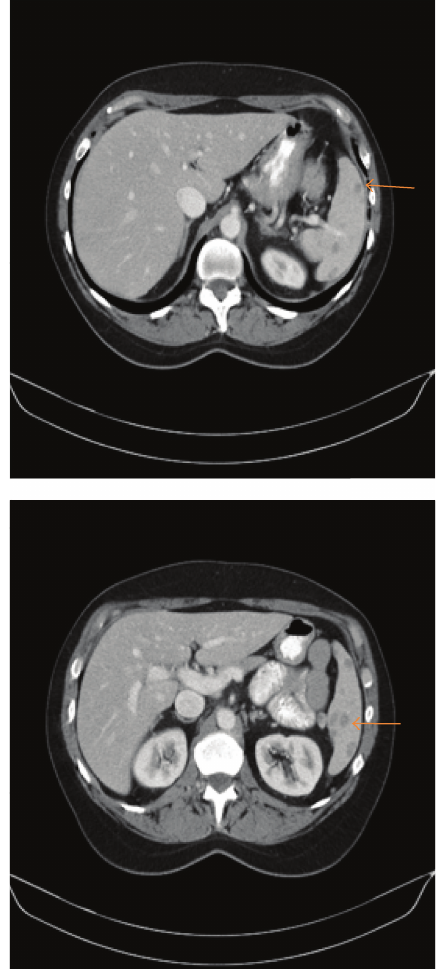
Figure 2: Abdominal imaging, revealing multiple splenic hypoden- sities.